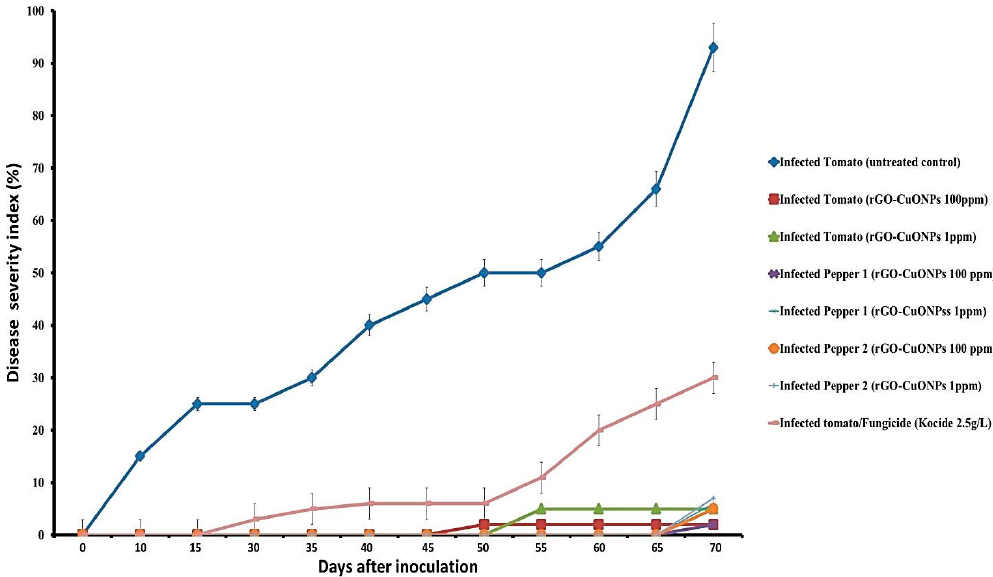
Figure 7. Disease severity index in % of tomato and pepper plants non-treated, treated with rGO-CuO NPs or the conventional fungicide Kocide and, then, challenged with F. oxysporum . Average and standard error of nine biological replicates are shown.